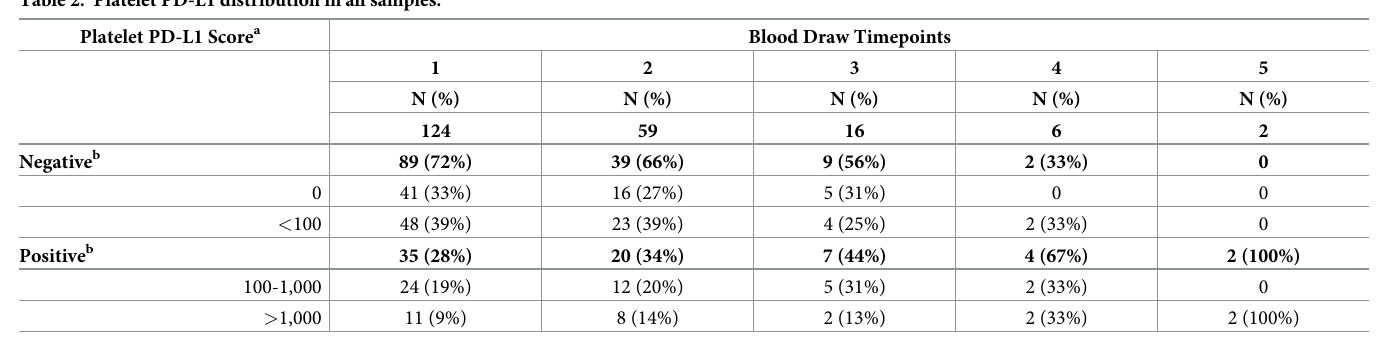
a Average platelet count/3 CellSearch Frames (see S1 File for details). b Arbitrary classification of platelet PD-L1 staining (see S1 File for details).